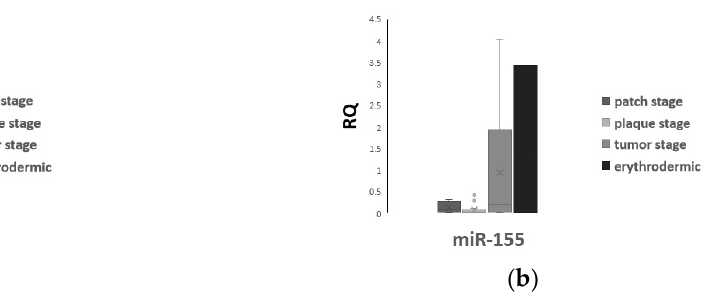
Figure 2. Plasma levels (mean ± SD) of miR-146a ( a ) and miR-155 ( b ) among MF patients with different skin lesions.